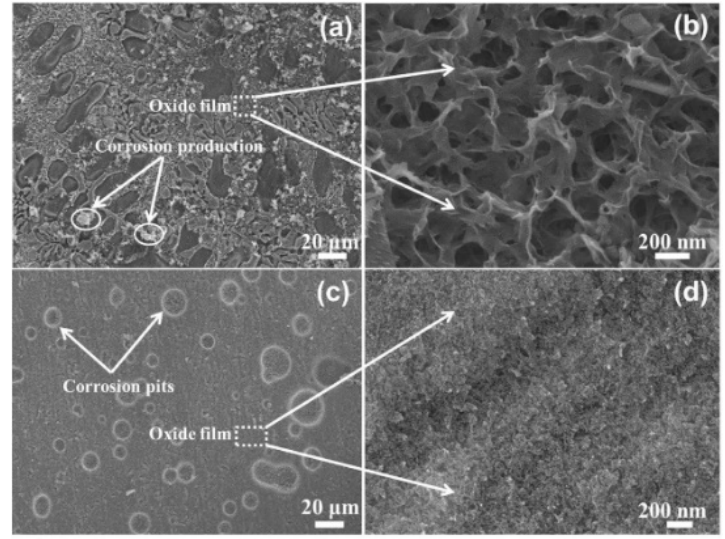
Figure 5. Corrosion morphologies of Al-12Si after 14 days immersion in 3.5 wt. % NaCl solution: ( a , b )